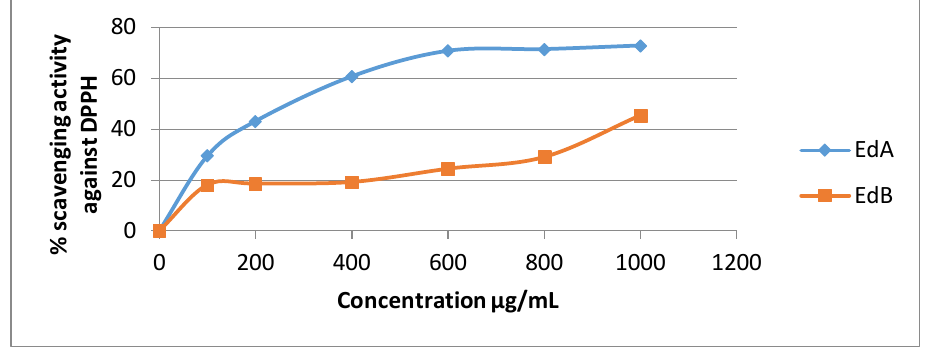
Figure 2. Inhibition of DPPH radical by the two extracts of E. dendroides at different concentrations.